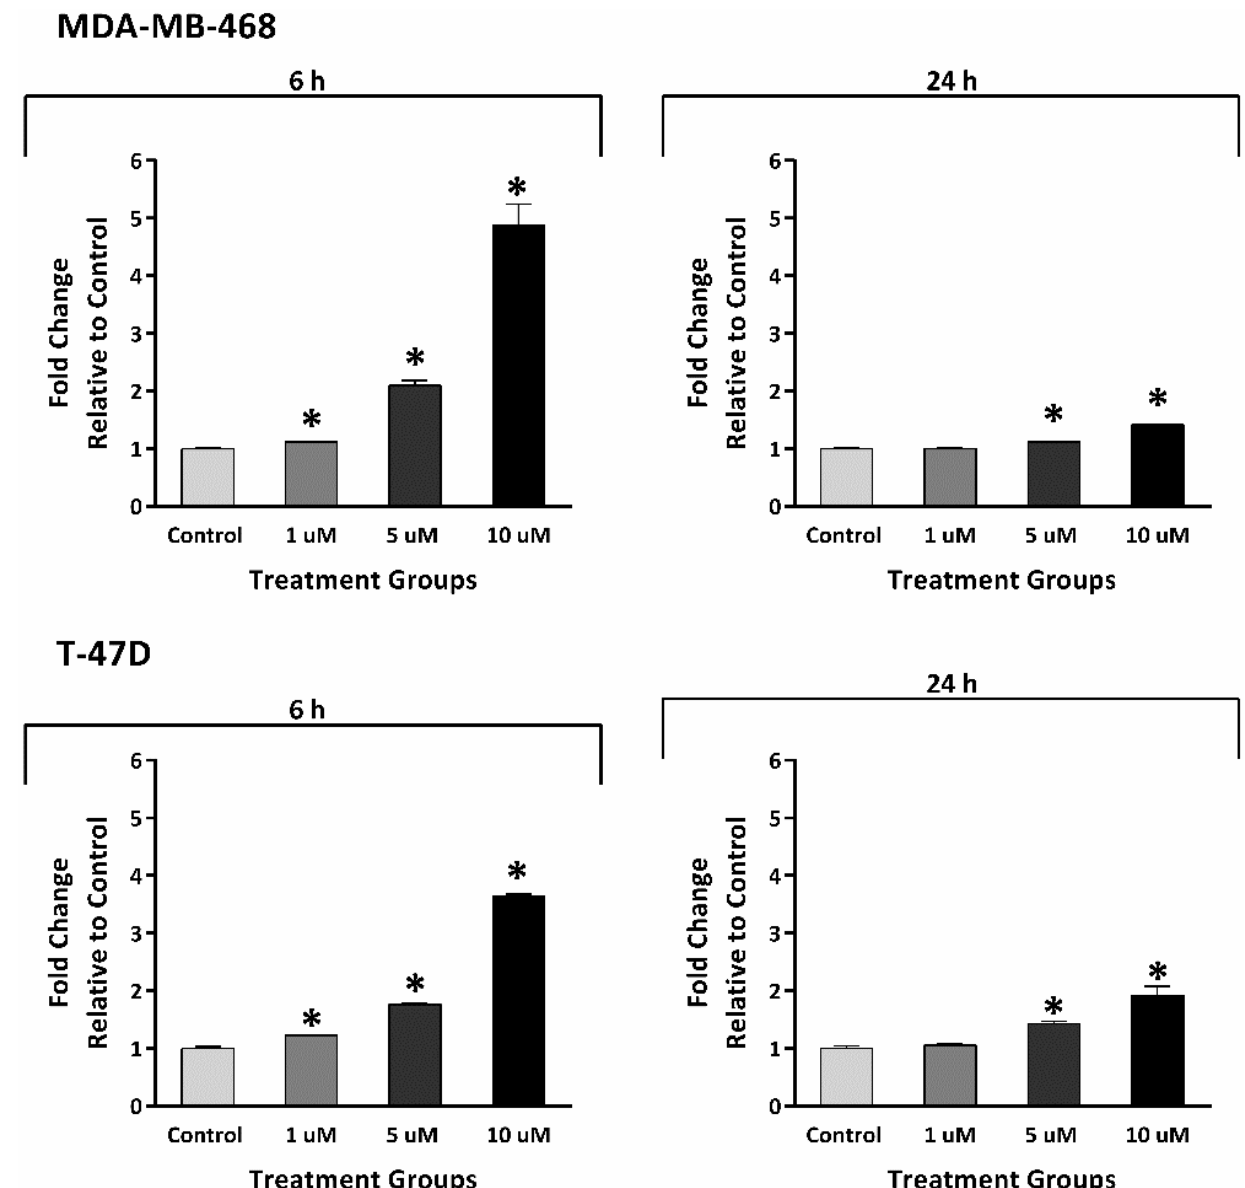
Figure 5. Mean ± SD bars showing a significant increase in ROS caused by TQ in MDA-MB-468 and T-47D in a concentration- dependent fashion. Higher ROS levels were seen in both cells after 6 h TQ treatments (1, 5, 10 µ M) compared to the control. After 24 h, TQ (5, 10 µ M) increased ROS but to reduced levels compared to 6 h treatments. No. trials ≥ 3; n = 2 per independent experiment. Asterisk indicates a statistically significant ( p ≤ 0.05) fold increase relative to control. 2.5. Thymoquinone Induced Early Temporary Aneuploidy in MDA-MB-468 Cell Cycle The early, significant ROS generation suggested that cancer cell proliferation (cell cycling) may be perturbed as early as within 6 h exposure of MDA-MB-468 cells to TQ. We therefore inspected MDA-MB-468 cell-cycle distribution after 6, 12, and 24 h exposure to 5 µ M TQ (Figure 6). After 6 h, cell-cycle histograms indicated that TQ induced significant early-onset perturbations including the appearance of aneuploid cells at G1, S, and G2/M phases. Fol- lowing 12 h, a stark increase in aneuploid cells was seen in all cell-cycle phases, accompanied by increased pre-G1 events. After 24 h, the percentage of aneuploid cells decreased to lower levels compared to 6 and 12 h treatment groups, while some pre-G1 events could still be detected. No aneuploid populations were observed in the untreated